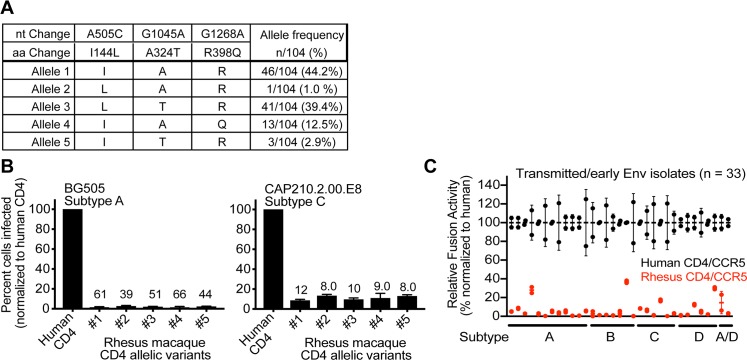
Rhesus macaque CD4 alleles are universally defective for HIV-1 entry.(A) Total RNA was isolated from the blood of 52 rhesus macaque individuals. CD4 was amplified from cDNA, and PCR products were sequenced to yield genotype information for each individual (104 chromosomes). Genotype information was used to phase SNPs using Phase 2.1 [81,82] in DNAsp v5 [83]. The table summarizes the unique CD4 alleles identified. For each allele, the residue encoded at each variable amino acid positions is noted. Unique alleles were cloned and further verified by Sanger sequencing. (B) Dog thymocytes (Cf2Th cells) stably expressing human CCR5 and the indicated rhesus macaque CD4 alleles (x-axis) were infected with HIV-1 (Q23ΔEnv-GFP) bearing a subtype A (BG505) or subtype C (CAP210.2.00.E8) Envelope (Env). The percent cells infected (GFP-positive) was measured by flow cytometry 48 hours post infection. Error bars represent the mean + SEM from two independent experiments, each with three technical replicates. Values above error bars represent fold decrease relative to human CD4 for those samples that passed significance thresholds (one-way ANOVA for repeated measures effect, Dunnett’s test; P < 0.05). (C) 293T cells transiently expressing diverse HIV-1 Envs (see S1 Table) and Cf2Th cells stably expressing the indicated CD4/CCR5 receptors were each transfected with plasmids encoding half of a split Renilla luciferase [79]. These two cell types were then cocultured to induce membrane fusion, which was detected by a luminescent product following the addition of the renilla luciferase substrate. A total of 33 Envs were tested from the following major HIV-1 subtypes: subtype A (n = 12), subtype B (n = 7), subtype C (n = 6), subtype D (n = 6), and subtype A/D (n = 2). The percentage of fusion was calculated relative to what was observed with human CD4/CCR5. Error bars represent the mean + SD, for which n = 2 (two technical replicates from one experiment). Data associated with this figure can be found in the supplemental data file (S6 Data). nt, nucleotide; aa, amino acid; CCR5, C-C motif chemokine receptor 5; GFP, green fluorescent protein.